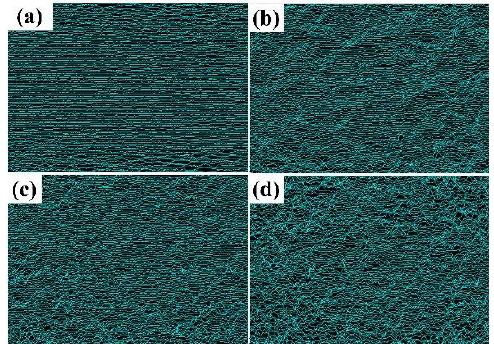
Figure 11. Surface morphology of specimens before and after shot peening: ( a ) NP specimen; ( b ) SP1 specimen; ( c ) SP2 specimen; ( d ) SP3 specimen.